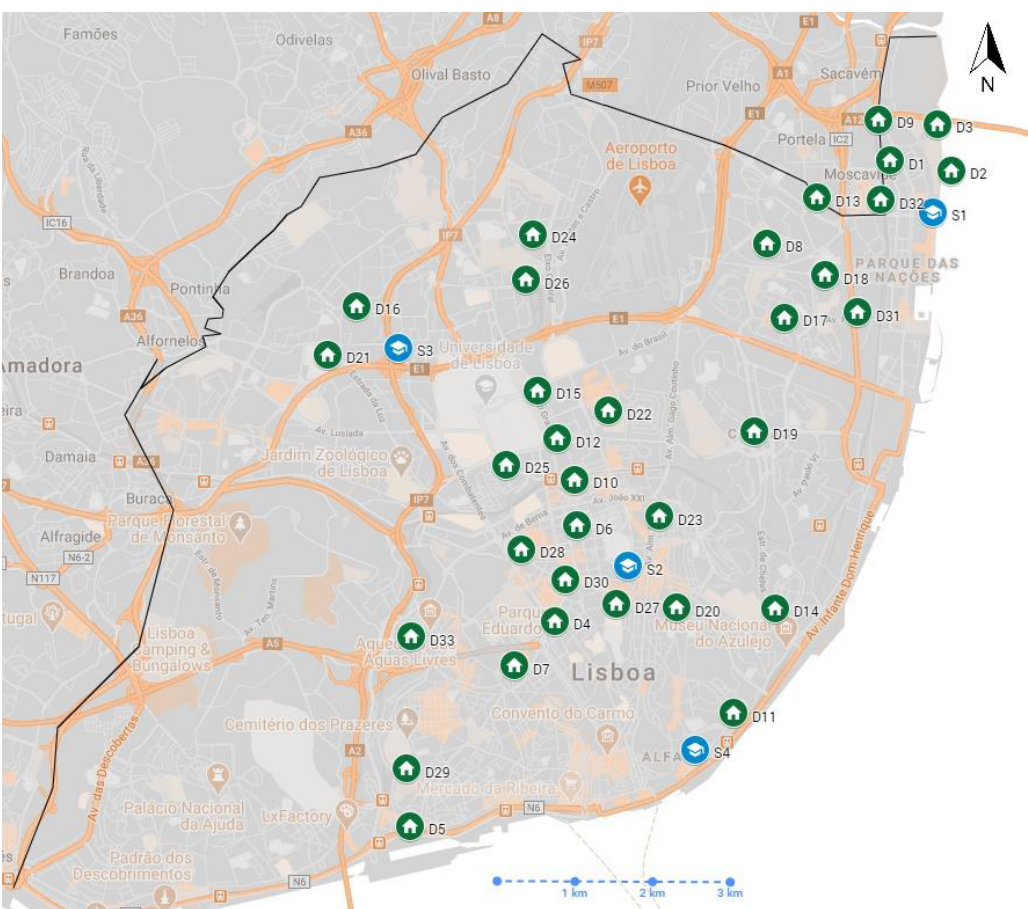
Figure 1. Location of the studied schools (blue) and dwellings (green) in Lisbon, Portugal.